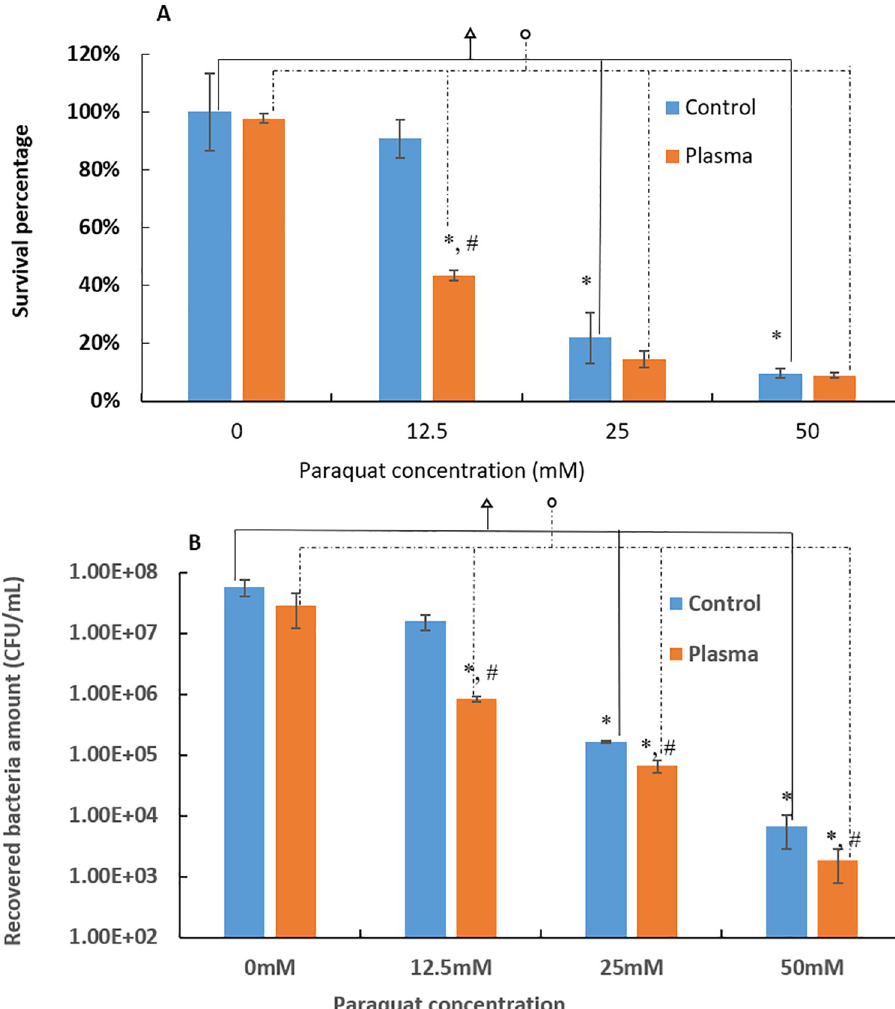
Fig 10. Biofilm recovery results under oxidative stress of paraquat from (A) MTT assay and (B) CFU counting assay for untreated and 1-min argon+1% oxygen plasma treated 3-day P . gingivalis biofilms. � denote the statistically significant difference (p < 0.05) compared with the control groups without paraquat treatment. # denotes the statistically significant difference (p < 0.05) between untreated controls and plasma treated groups. denotes the statistically significant differences among different paraquat doses for non-plasma treated biofilms with p < 0.05 according to ANOVA Tukey test. denotes the statistically significant differences among different paraquat doses for plasma treated biofilms with p < 0.05 according to ANOVA Tukey